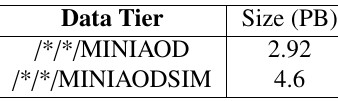
Table 1. Size of all datasets in di ff erent MINIAOD Data tiers. Data obtained using the CMS Data